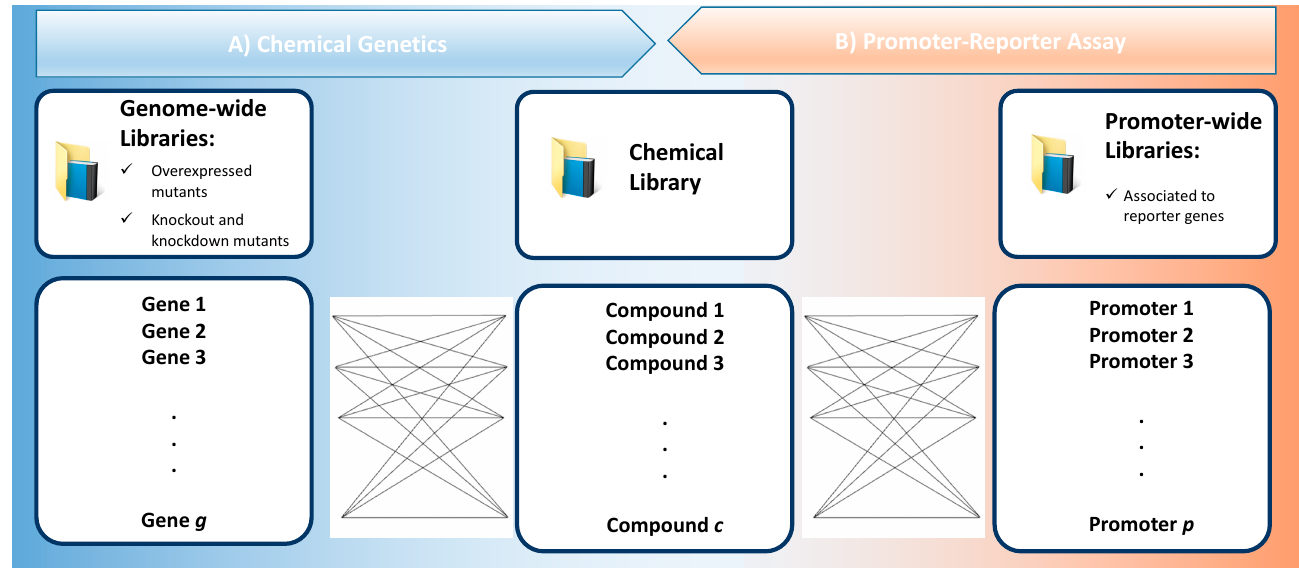
Figure 2. High-throughput screening assays based on genome-wide ( A ) or promoter-wide ( B ) bacterial mutant libraries that are tested against a chemical library. Ideally, the total number of genes (g) or promoters (p) considered in a screening campaign are minimized to reduce the workload, although this often yields less information. On the other hand, the diversity of all the compounds that constitute the chemical library (c) should be increased, as this improves the likelihood of discovering novelty.